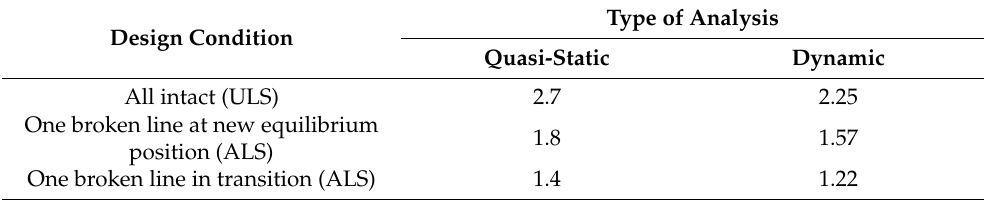
Table 13. ABS’s safety factor of mooring lines for offshore floating production